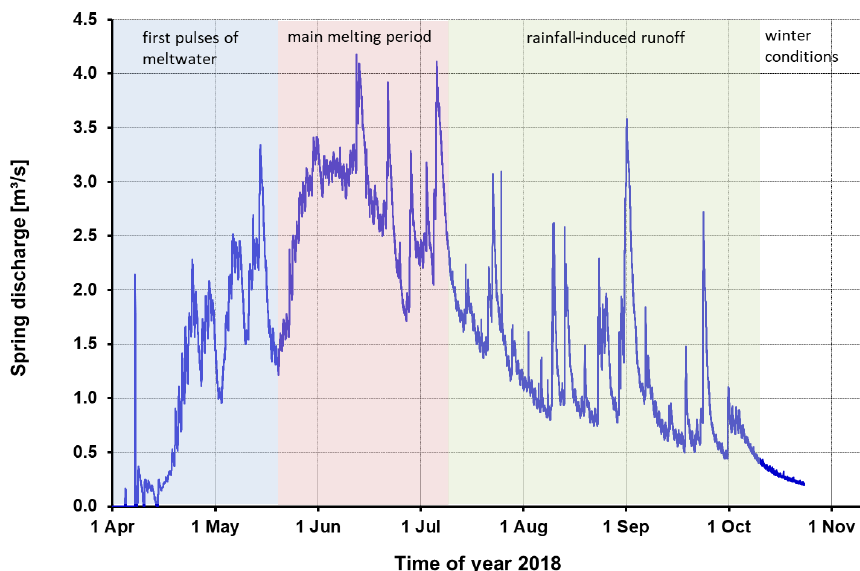
Figure 6. Spring discharge characteristics of the Partnach spring during 2018.